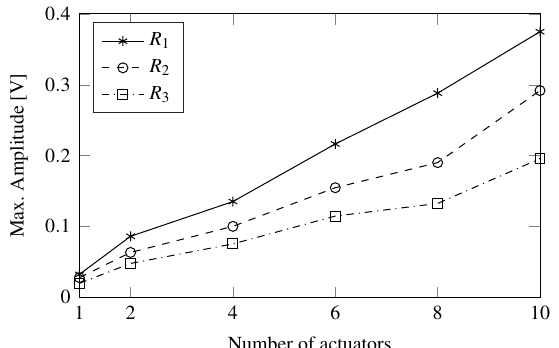
Figure 7. Maximum amplitudes acquired at three different distances from the phased-array (i.e., R 1 = 170 mm, R 2 = 270 mm, and R 3 = 400 mm) in the transmission beamforming tests. The main beam is steered at 60 ◦ and different number of actuators are